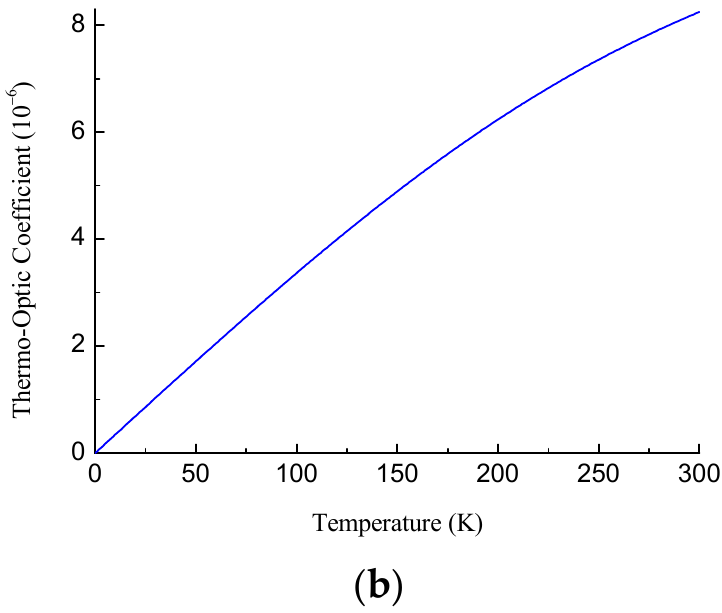
Figure 2. ( a ) Refractive index change and ( b ) thermo-optic coefficient of pure fused silica at 1.55 µ m as a function of temperature.